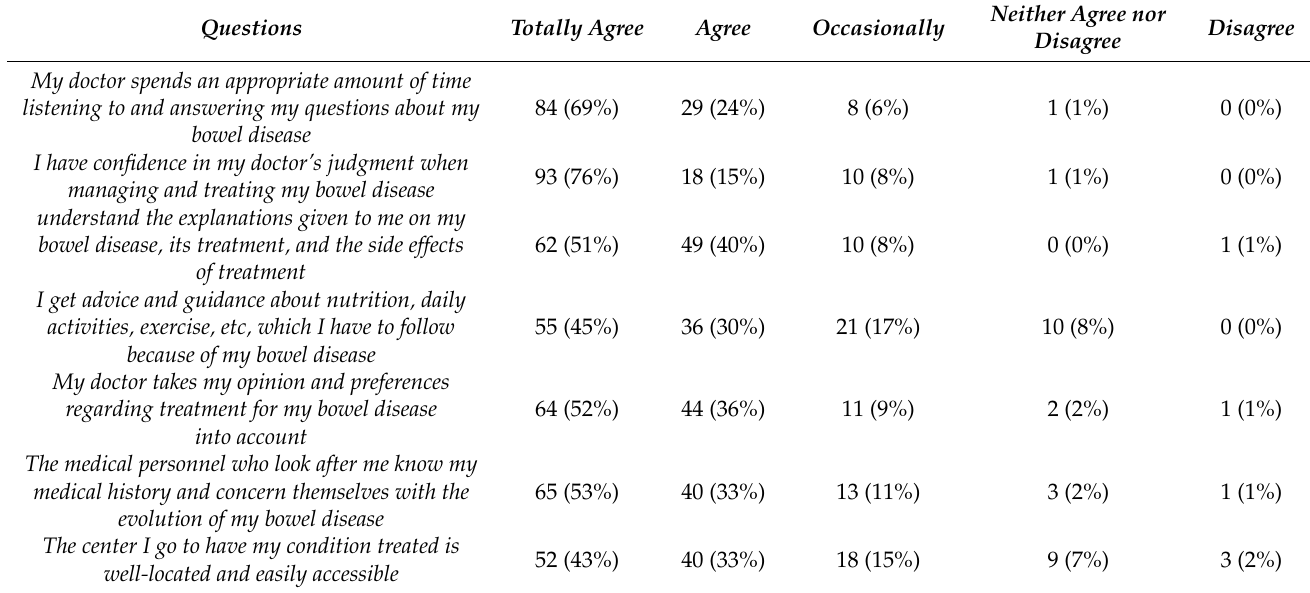
Table 5. Distribution of adolescent responses to CACHE